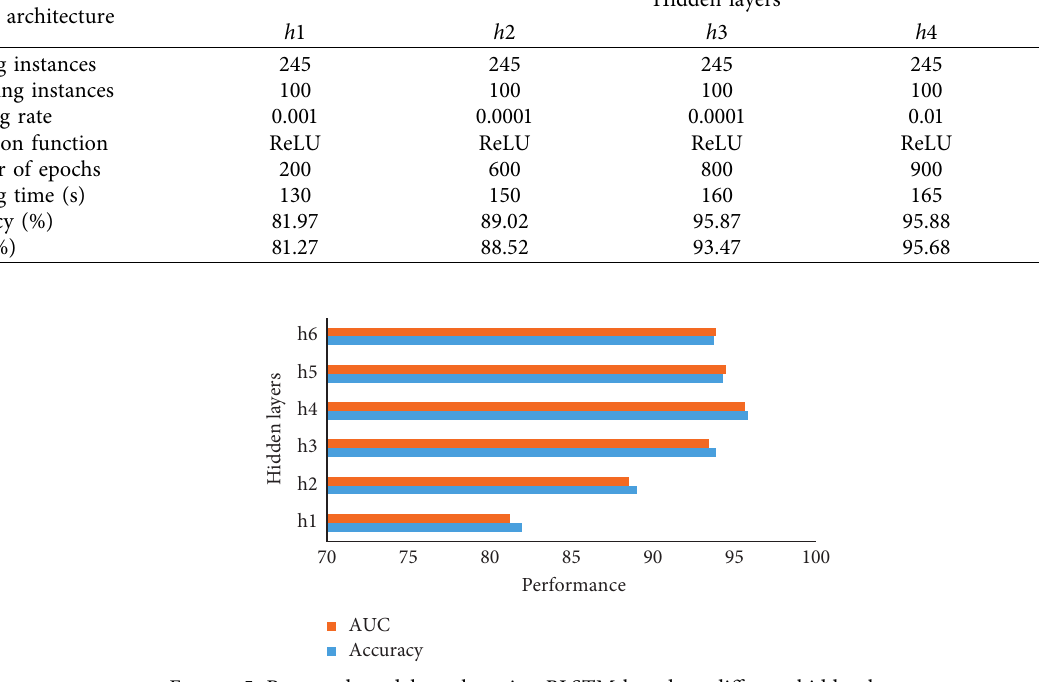
Figure 5: Proposed model results using BLSTM based on different hidden layers.